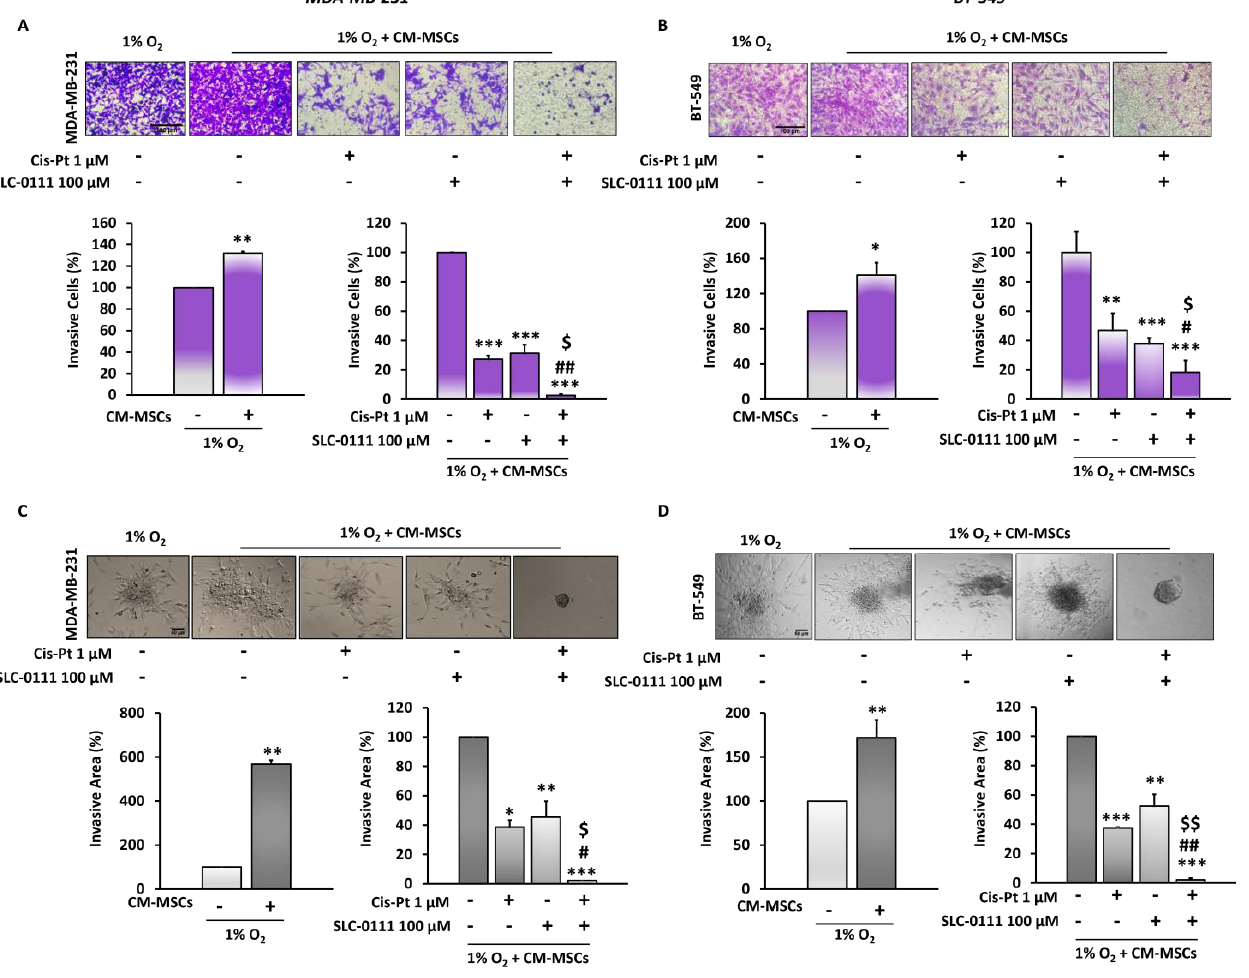
Figure 4. The addition of SLC-0111 to Cis-Pt decreases CM-MSC-induced TNBC cell invasiveness. Invasion of MDA-MB-231 ( A ) and BT-549 ( B ) cells in 2D, was performed by using a Boyden chamber containing inserts of polycarbonate membranes with 8 µ m pores coated with Matrigel. TNBC cells were grown for 72 h under hypoxic (1% O 2 ) conditions in the presence of CM-MSCs and treated with SLC-0111 (100 µM), Cis-Pt (1 µM) or a combination of the two drugs. Medium containing 10% FBS was added to the lower chamber as chemoattractant. Magnification 10 x, scale bar = 100 µm. MDA-MB-231 ( C ) and BT-549 ( D ) spheroids were embedded in Matrigel and treated for 48 h as described above. Magnification 20 x, scale bar = 50 µm. All the data are expressed as percentages, considering the untreated control cells as 100%. Bars depict mean ± SD of three independent experiments (vs. untreated * p < 0.01, ** p < 0.001, *** p ≤ 0.0001; vs . Cis-Pt $$ p < 0.0001, $ p < 0.001; vs. SLC-0111 # p < 0.001, ## p ≤ 0.0001 ).